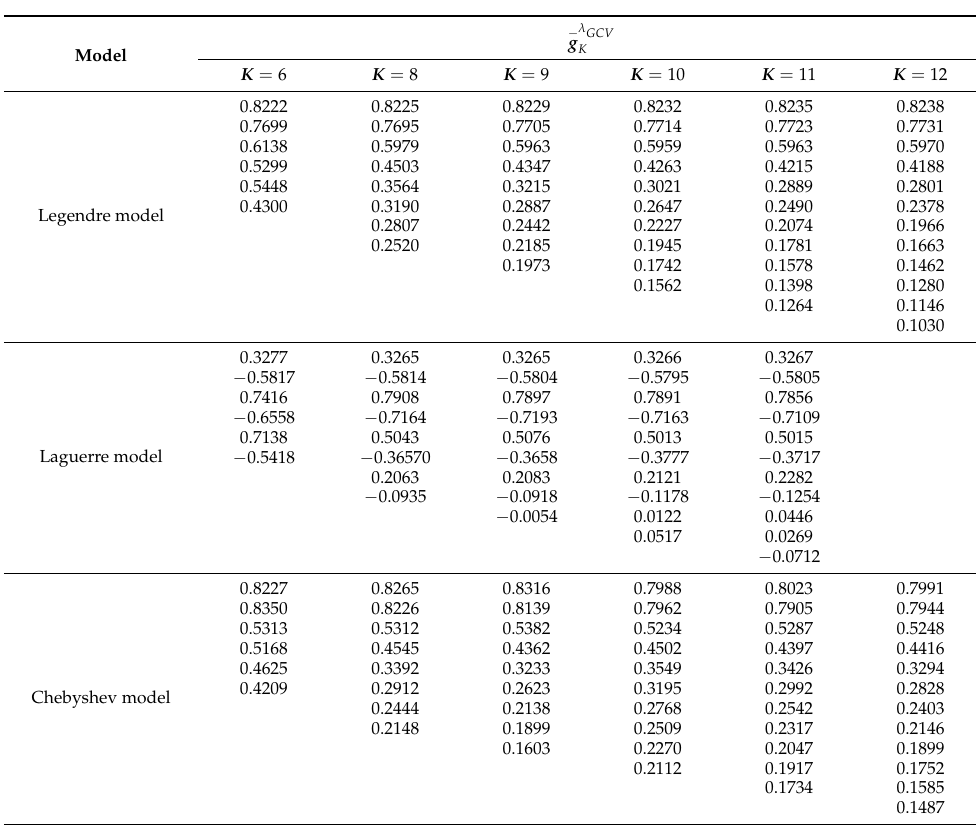
Table A2. Optimal parameters